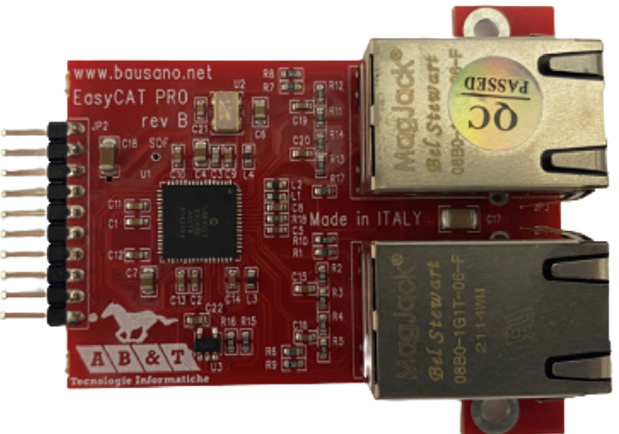
Figure 12. EasyCAT PRO Shield allows for EtherCAT networking capability between the high and low-level